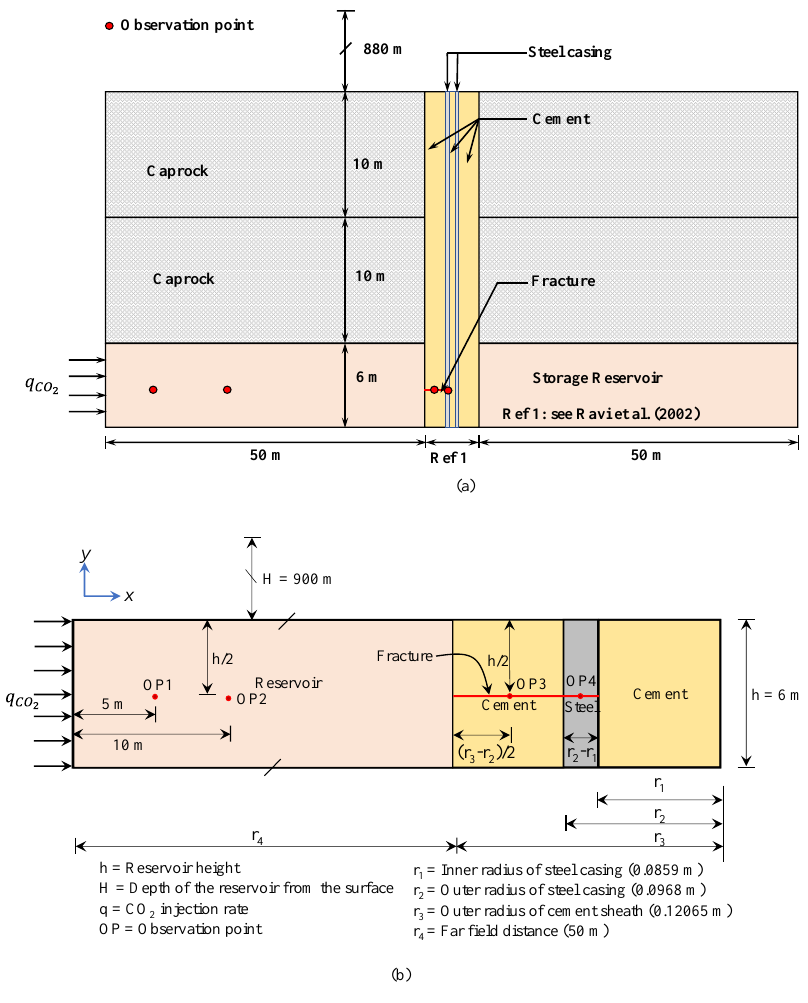
Figure 10. ( a ) Schematic diagram of the cross-section of the compromised well and ( b ) schematic dimensions of the cross-section and locations of observation points (see also Ravi et al. [45]).